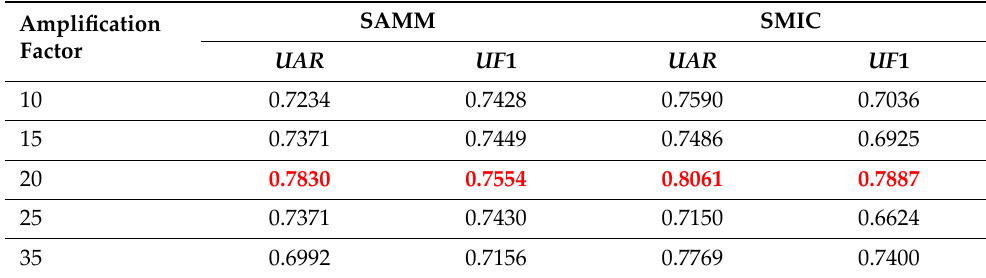
Table 9. Performance of DS‑3DCNN (with domain adaptation) with different amplification factors in EVM.